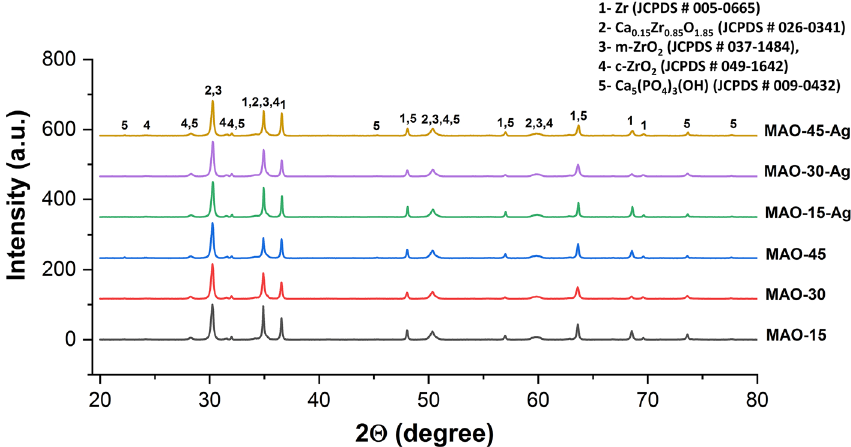
Figure 2. XRD spectra of the MAO and AgNPs-doped MAO